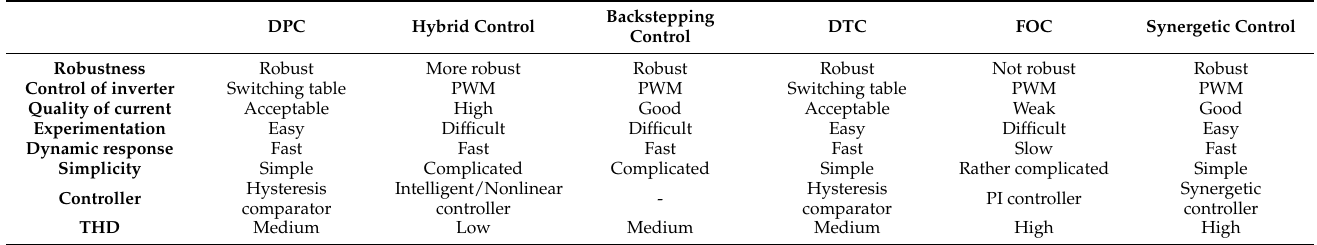
Table 1. A comparative study between the different methods used in wind